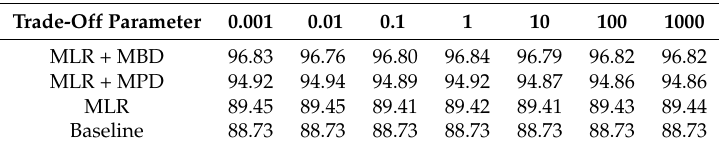
Table 15. MLR trade-off parameter discussion on MLII.